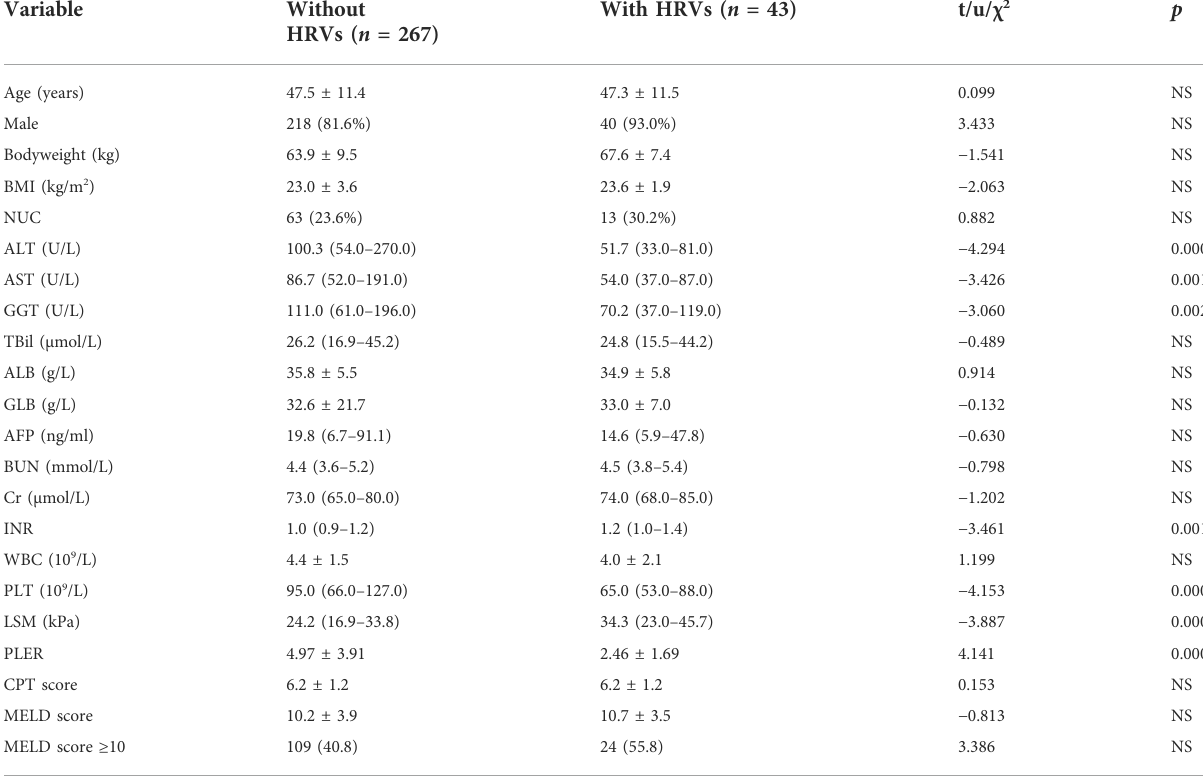
TABLE 1 Baseline characteristics of patients with HBV-related cirrhosis with/without HRVs beyond Baveno VI criteria. Variable Without With HRVs ( n = 43) HRVs ( n = 267)